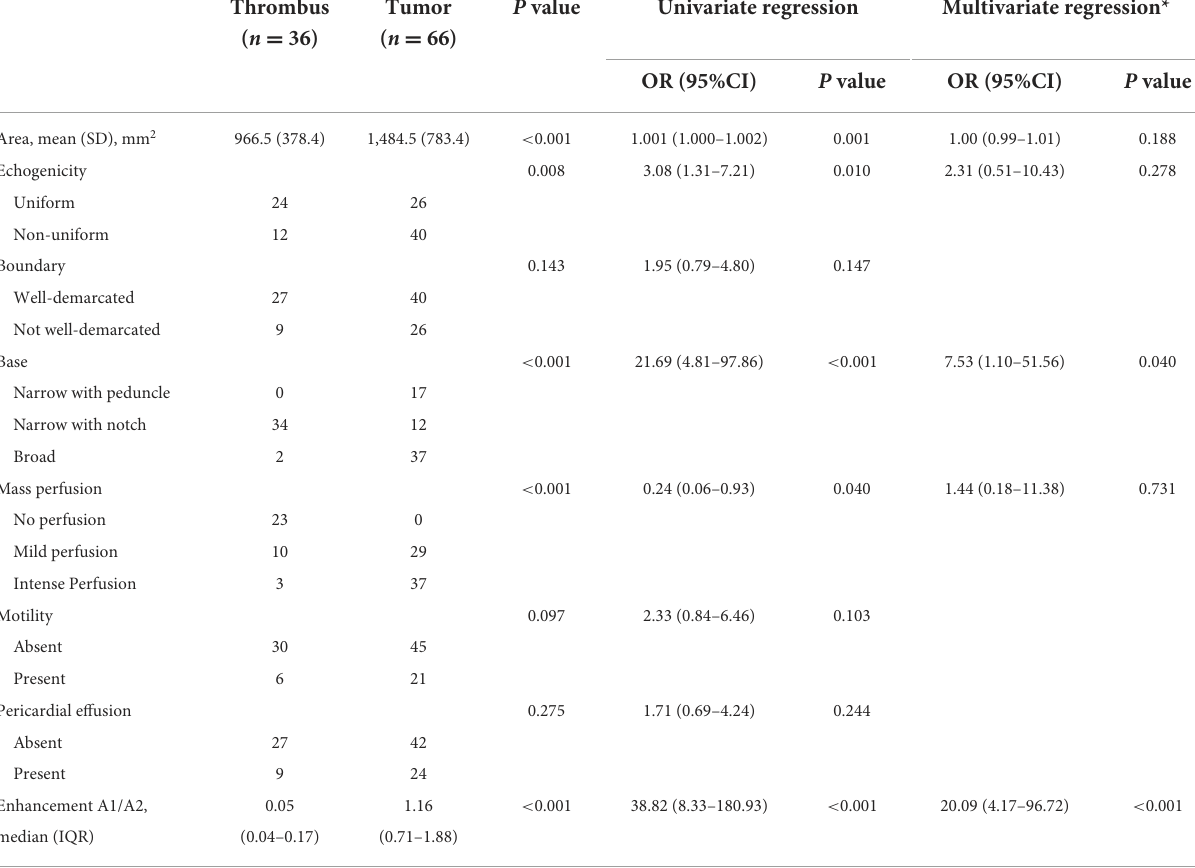
TABLE 2 Comparison of echocardiographic parameters between thrombus and tumor.